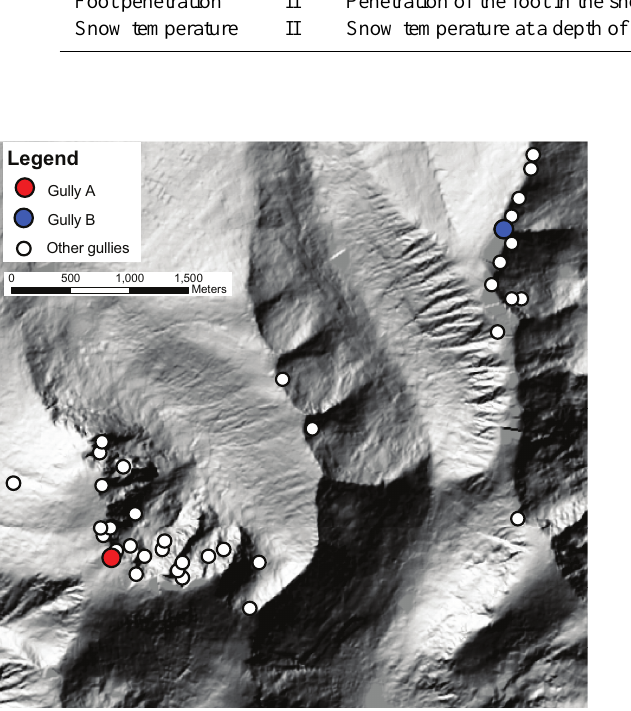
Fig. 1. The hillshade of the DEM of the Lochaber region and locations of the gullies where avalanches are typically observed. Two particular gullies used to illustrate some properties of developed predictive system throughout the paper are marked with A (“No. 3 Gully” on Ben Nevis face) and B (“The Chancer” on Aonach